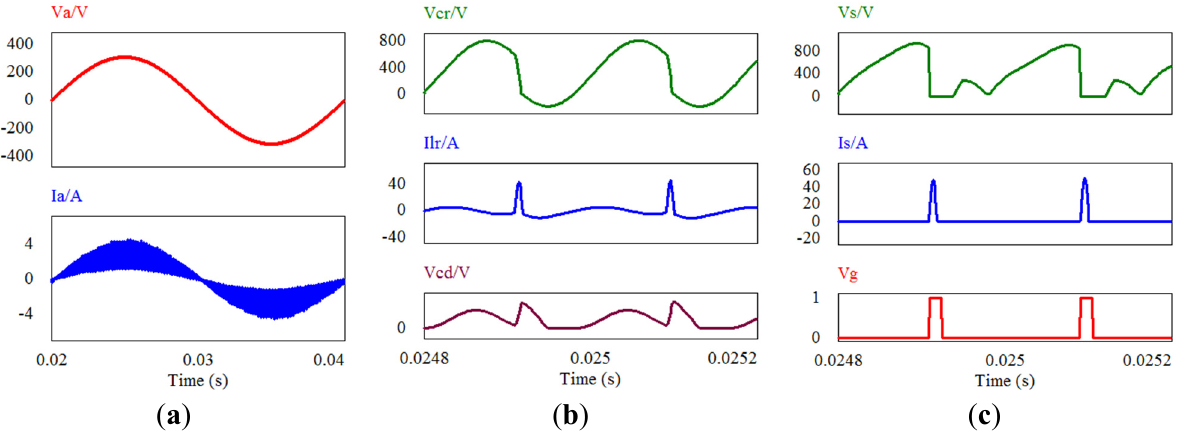
Figure 13. Simulation waveforms of the floating voltage charging stage. ( a ) input phase voltage and input phase current; ( b ) resonant capacitors voltage and resonant inductor current and ( c ) voltage and current of IGBT and gate